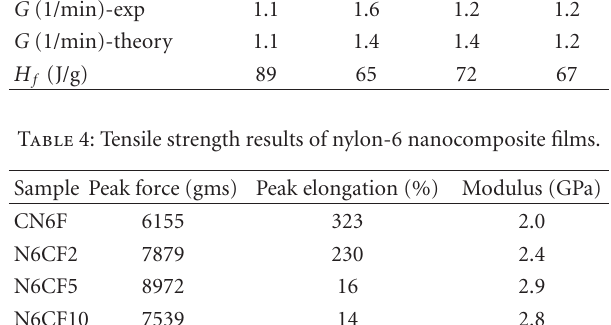
Figure 8: Tensile strength results of nylon-6 nanocomposite films (color figure can be viewed in the online issue).